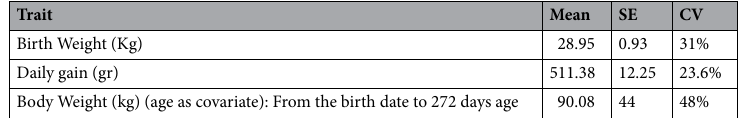
Table 2. ANCOVA of body weight (kg) among five regions of the central desert of Iran. *Age of recording included as covariate and body weight are evaluated at the Age = 155.98 days-old.